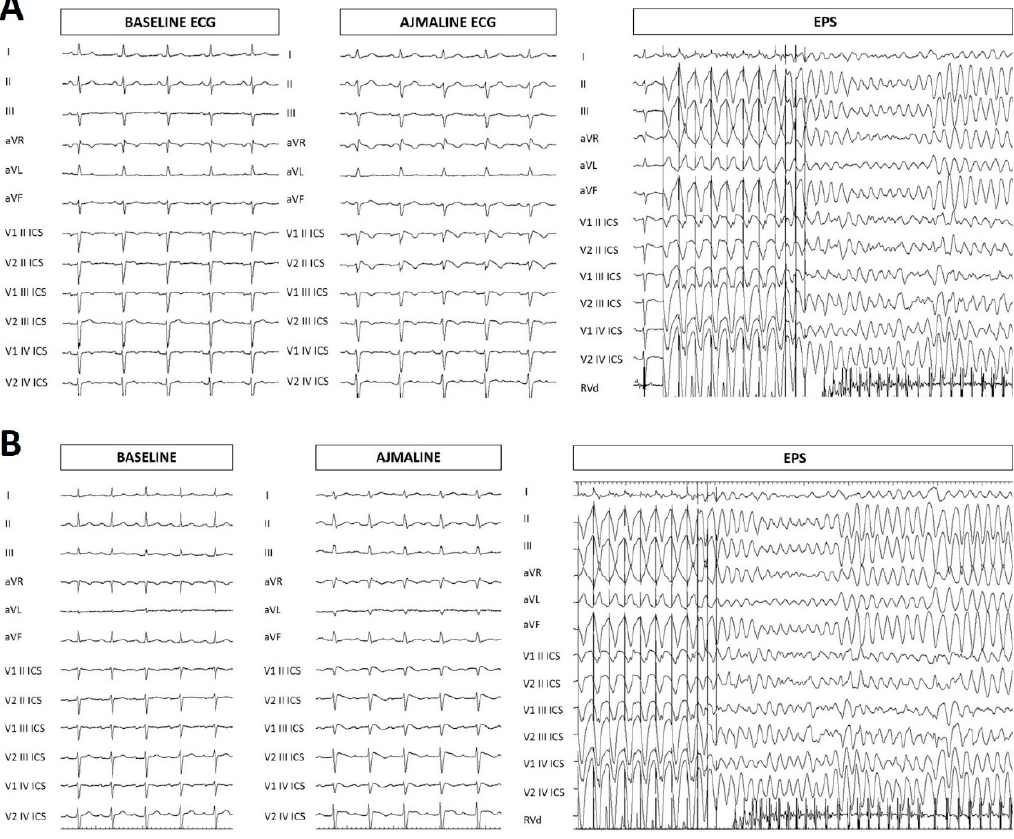
Figure 2. Electrocardiogram (ECG) at baseline, after ajmaline administration, ventricular tachycardia/fibrillation (VT/VF) inducibility during electrophysiological study (EPS). ( A ) Proband. ( B ) Proband’s cousin, family member II-1.